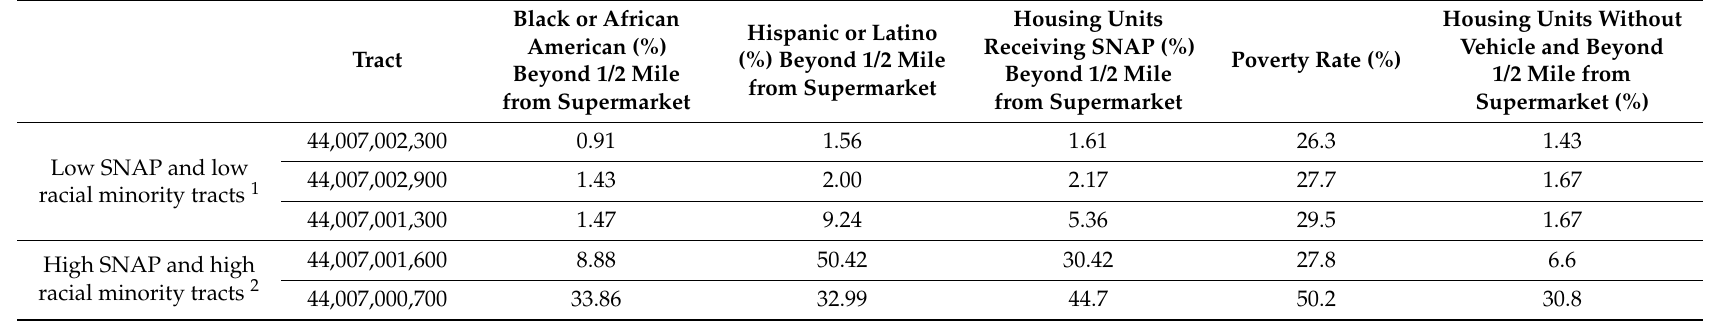
Table 1. Characteristics of five selected tracts in Providence, Rhode Island